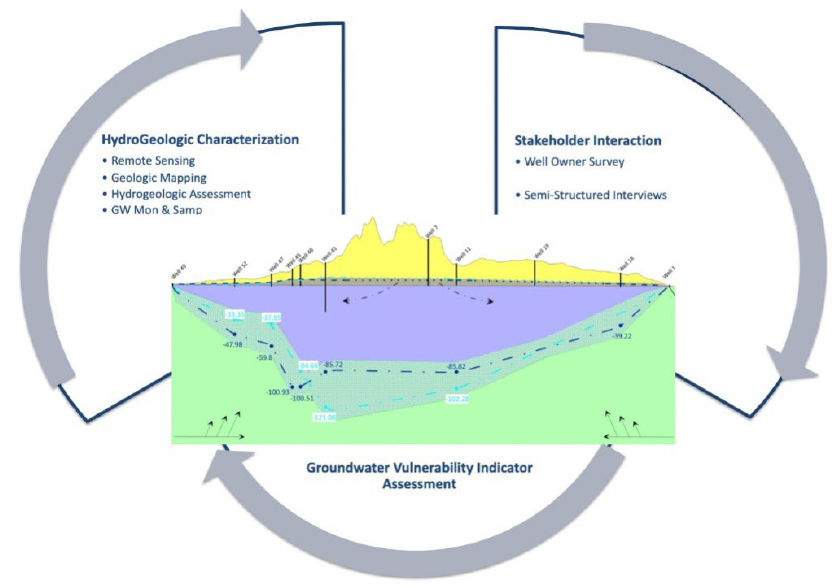
Figure 1. FLAP: Research Data Acquisition [15].